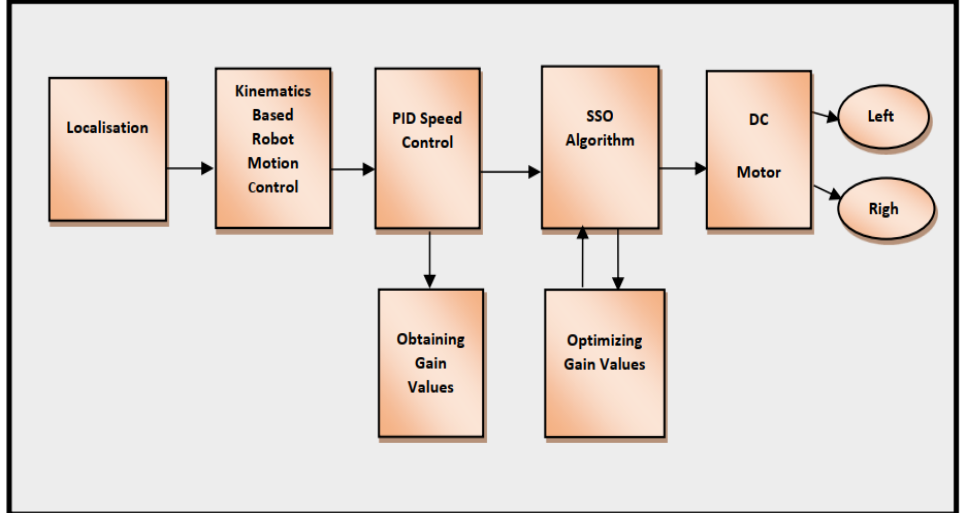
Figure 1. Proposed